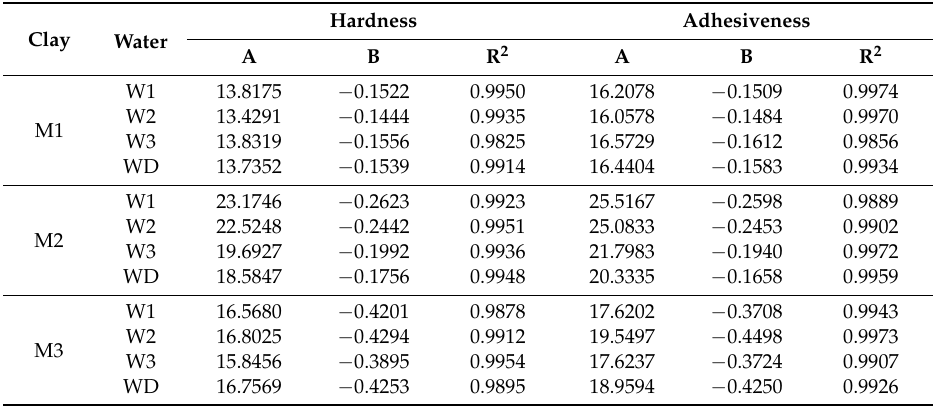
Table 5. The intercept (A), slope (B) and determination coefficients (R 2 ) of the regression lines for hardness (or adhesiveness) by types of clay and